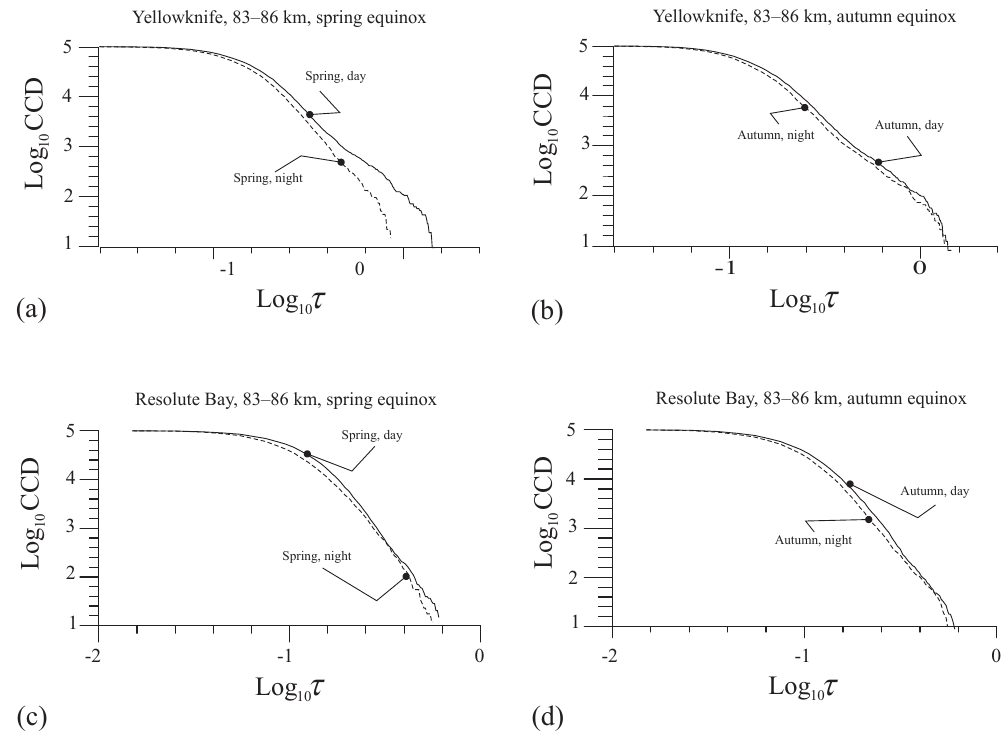
Figure 10. Log 10 CCD graphs (as in Fig. 2) for the two equinoxes at Yellowknife and Resolute Bay for 83–86km altitude. “Spring equinox” refers to the two months of March and April, while “autumn equinox” refers to the combined results from September and October. Daytime values are shown by solid lines and night-time values by broken lines. Similar results were found for 76–80 and 80–83km. Night-time CCD values were always less than daytime ones for log 10 τ > −